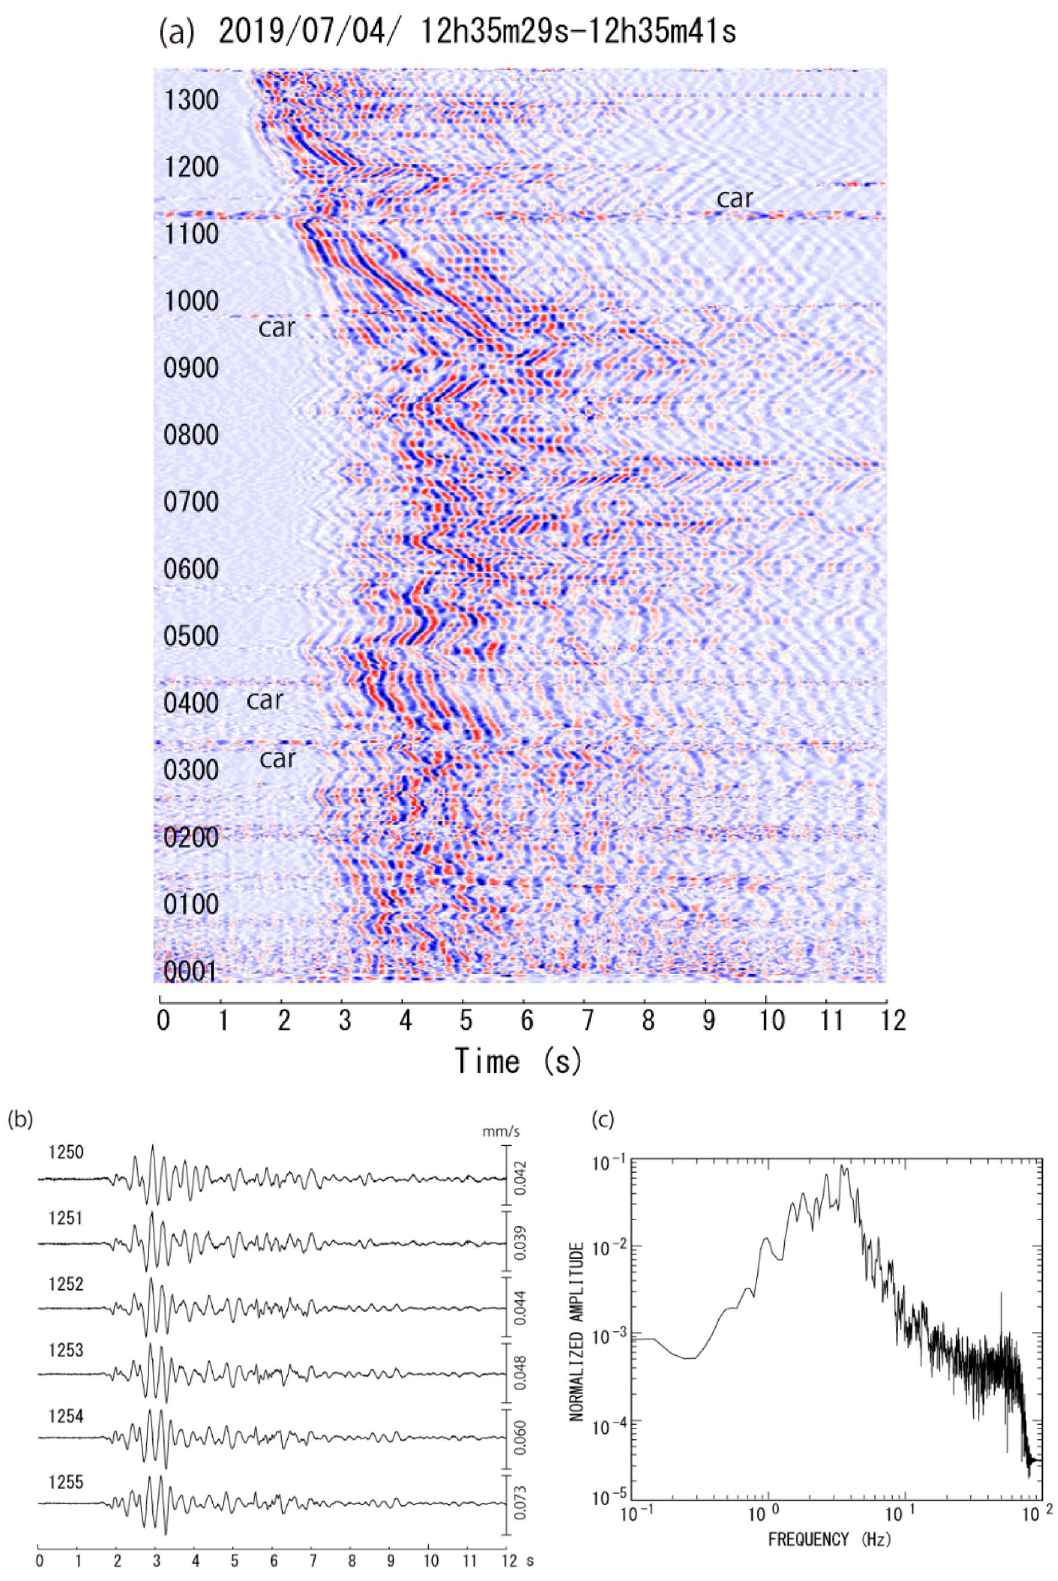
Figure 2. ( a ) Record section for the volcanic earthquake on July 4, 2019. ( b ) An example of a seismogram of the volcanic earthquake recorded at nearby measurement points. The amplitudes are converted by comparing the records of a short-period seismometer that was set closely at these measurement points. ( c ) Amplitude spectrum of the volcanic earthquake. Large amplitude signals that continue from the beginning to the end at several measurement points shown in ( a ) are noise generated by moving cars. The numbers shown at the left in ( a ) and ( b ) represent the measurement